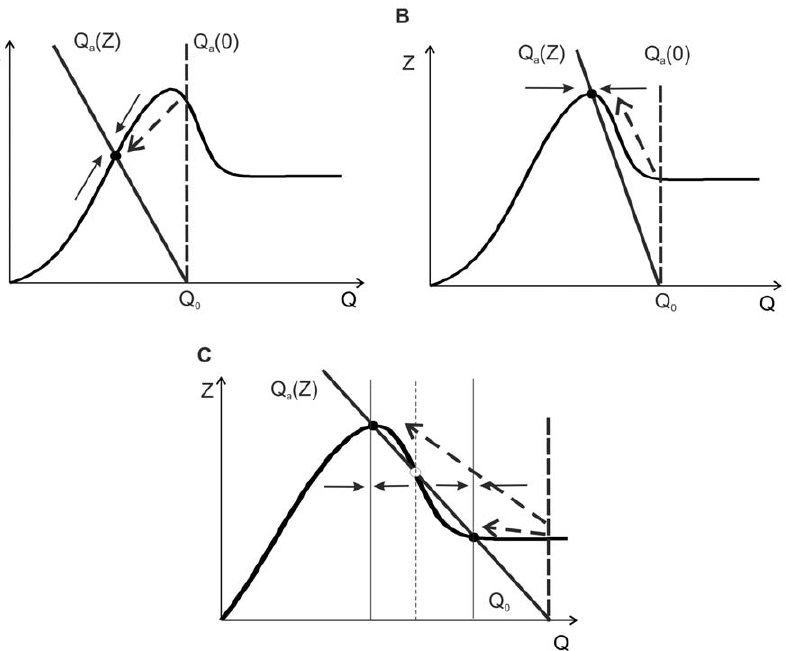
Figure 6. Schematic figures of equilibrium curves illustrated in the phase plane (Z,Q) . A. Single fixed point balance leading to a decrease of the ECM concentration. B. An increase of the ECM concentration due to deactivation of proteases for higher initial activity. C. Three fixed point (bistable) balance.